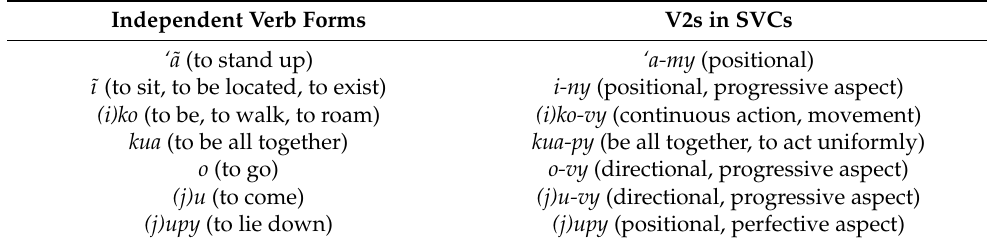
Table 2. Meanings of Mbya serial verb construction (SVC)